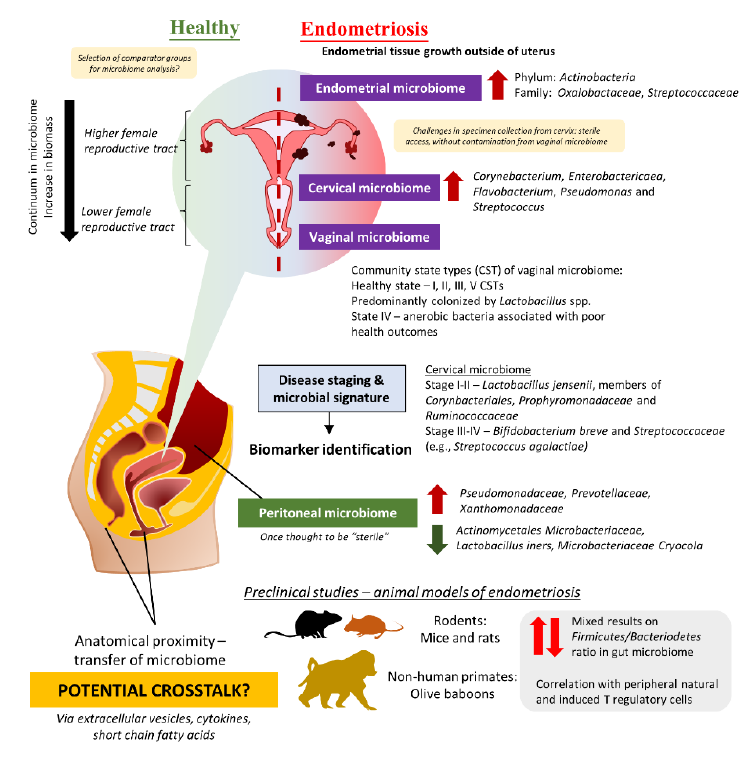
Figure 1. The potential role of the microbiome in endometriosis.